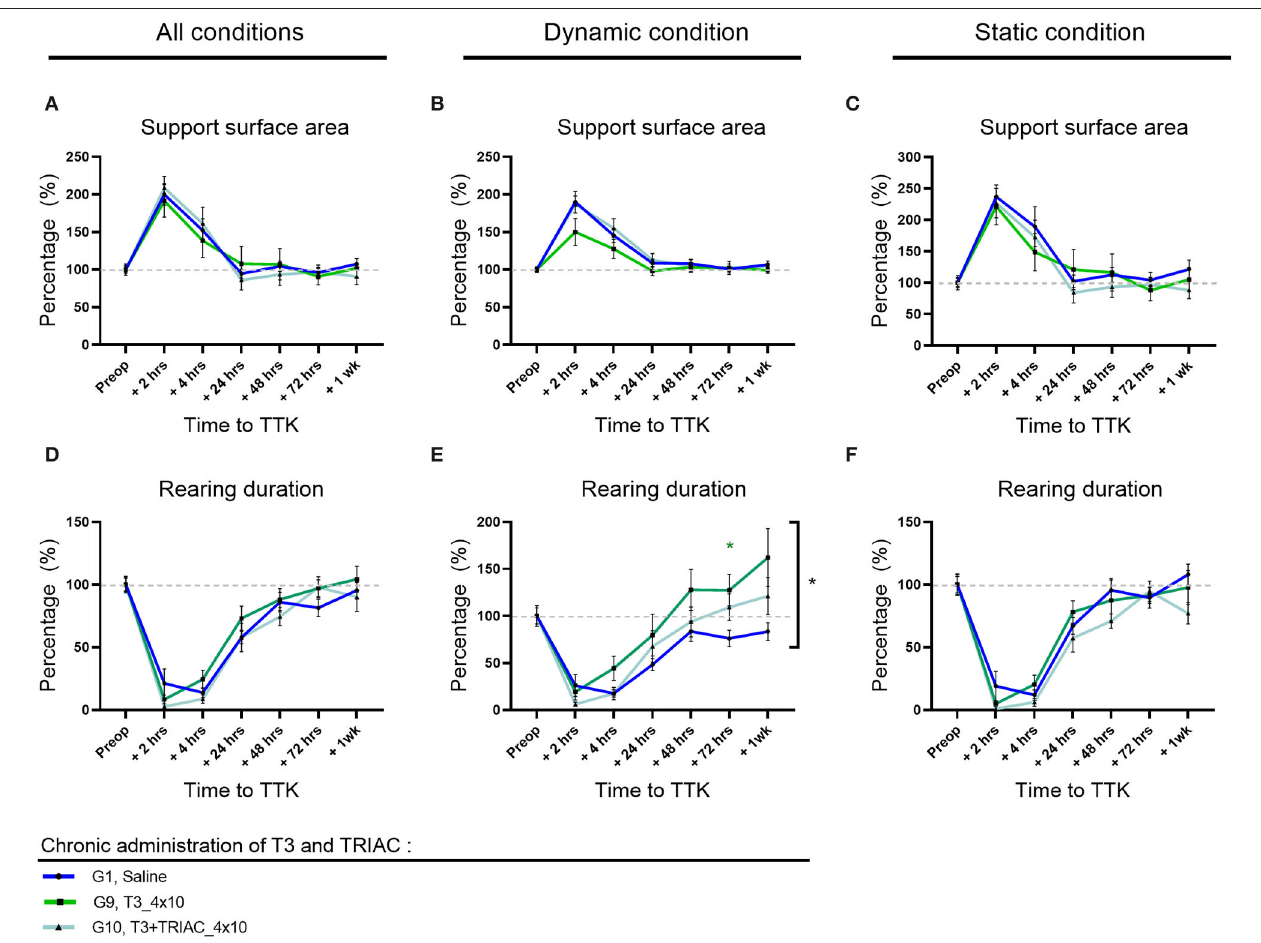
FIGURE 6 | Effect of T3 alone or a combination of T3 + TRIAC treatments on the support surface area (A–C) and rearing duration (D–F) in vestibular defective rats. Statistically significant differences are assessed using two-way ANOVA with Tukey post-hoc , * p < 0.05. n = 44.